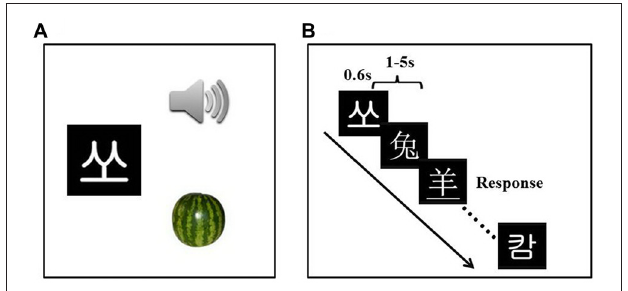
FIGURE 1 | Experiment design and examples of the stimuli. Participants received the artificial language training (A) for 12 days (1 h per day). The passive viewing task (B) was administered three